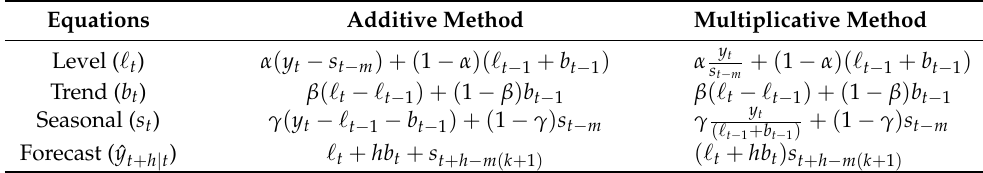
Table 1. The smoothing and forecast equations of the Holt–Winters method. Equations Additive Method Multiplicative